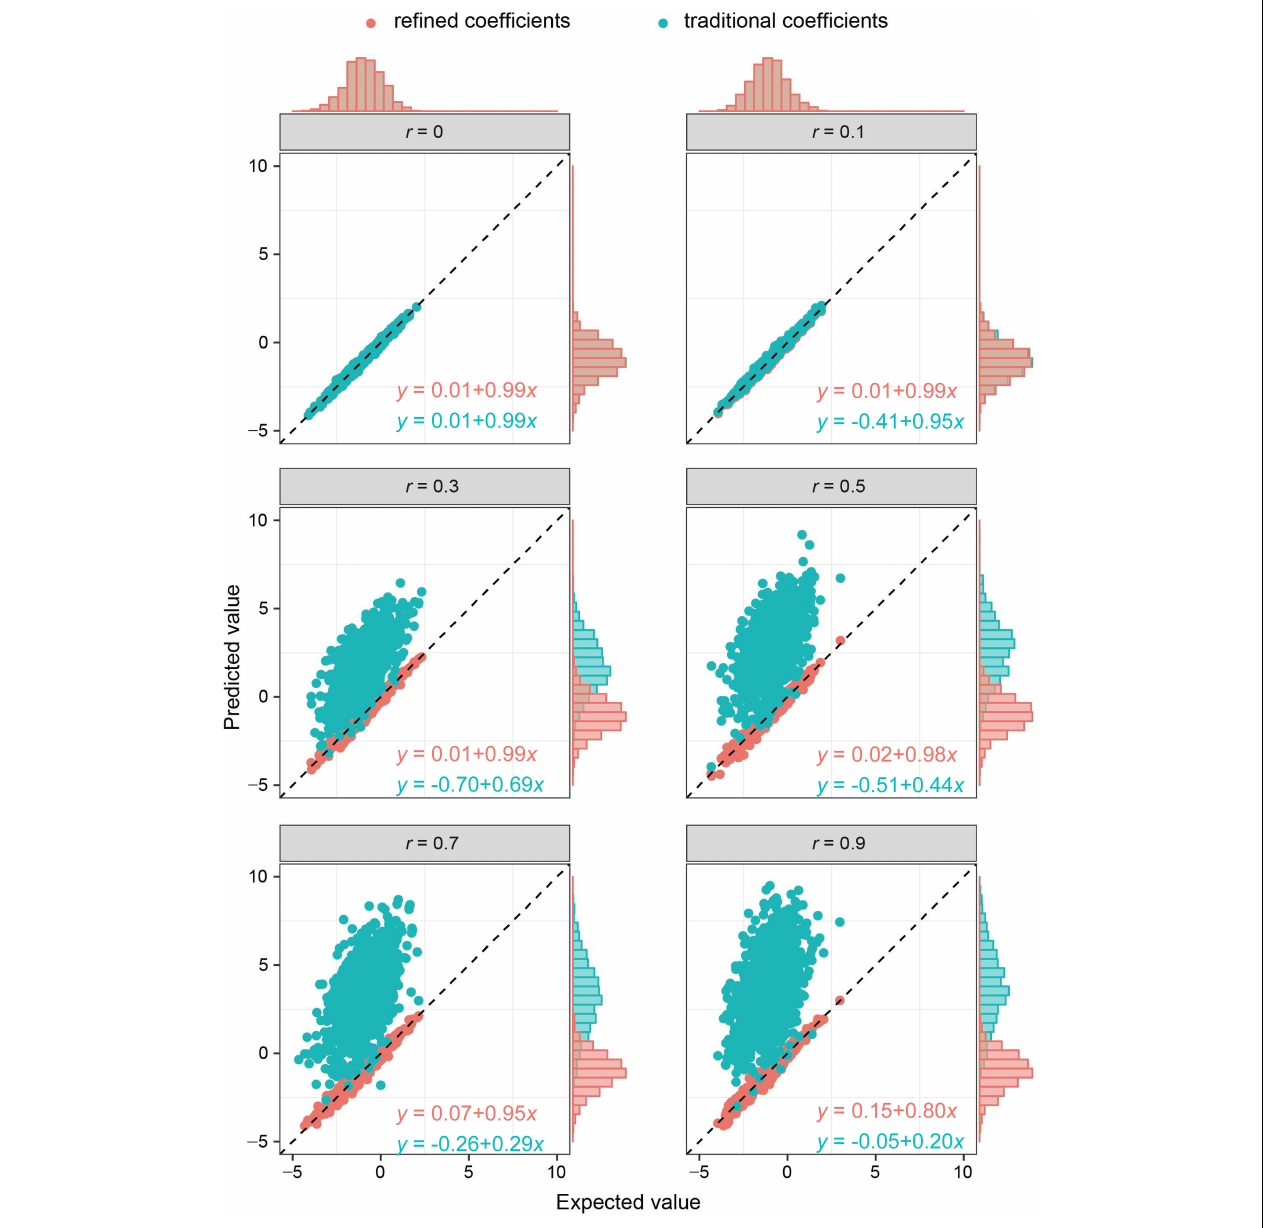
FIGURE 2 | Comparison of refined and traditional coefficients under different correlation structures. Expected values are the regression coefficients obtained from the multivariable regression model with all the variables used to generate dependent variable Y plotted against predicted values obtained from the refined method (refined coefficients) and traditional single-locus analyses (traditional coefficients). Refined and traditional coefficients were compared with the bias from expected coefficients under different correlation structures through a regression model. Red equation represents the relationship between expected coefficients and refined coefficients, and green equation represents traditional